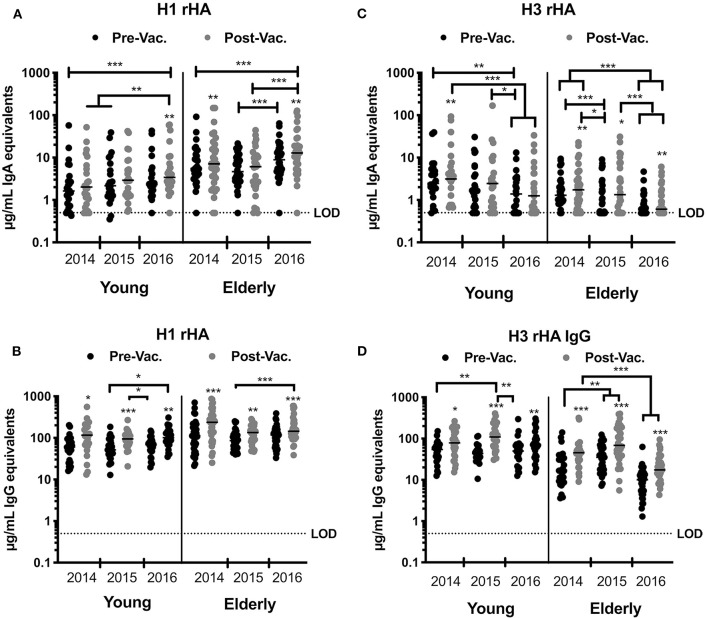
IIV recurrent vaccination induces H1N1-specific IgA and IgG antibodies in young and elderly subjects. HA-specific IgA and IgG levels in the serum of young and elderly donors was measured by ELISA. (A,B) Serum samples from young adults and elderly subjects collected prior and 28 days post-vaccination for three consecutive years were tested for anti-HA specific IgA (A) or IgG (B) antibodies against the H1N1 vaccine strain (CA/09) rHA. (C,D) Serum samples from young adults and elderly subjects collected prior and 28 days post-vaccination for three consecutive years were tested for anti-HA specific IgA (C) or IgG (D) antibodies against H3N2 vaccine strains rHA (TX/12 in 2014, Switz/13 in 2015, and HK/14 in 2016). Box and whisker plots show the median with upper and lower quartile of the μg/mL IgA or IgG equivalent based on a human reference serum standard. *p < 0.05, **p < 0.01, ***p < 0.001.